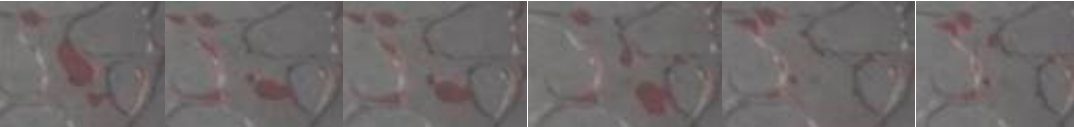
Figure 15. Variation of drop-like remaining oil in the same area with different displacement rates (the time from left to right was 729, 1160, 1500, 1990, 2300, and 2633 s ) . For the remaining columnar oil, at the displacement rate of 0.1 mL/min (i.e., when the cumulative PV number is 11.2), part of the remaining columnar oil is displaced at the end of displacement, but about half of the remaining oil remains in the pores. When the displacement rate is increased to 0.2 mL/min (i.e., when the cumulative PV number is 20.7), the remaining columnar oil is unchanged. This shows that this part of the remaining oil cannot be used in this displacement rate. When the displacement rate continues to increase to 0.3 mL/min (i.e., when the cumulative PV number is 39.2), the remaining columnar oil still cannot be driven. When the displacement intensity is 0.4 mL/min (i.e., the cumulative PV number was 56.6), the shape of the remaining oil pair changes significantly, and the area of the remaining oil becomes smaller. When the displacement intensity is increased to 0.5 mL/min (i.e., the cumulative PV number was 80.0), the remaining oil cannot be displaced (see Figure 16). When the water injection rate increases from 0.05 to 0.5 mL/min, the columnar remaining oil area decreases from 0.098 to 0.043 mm 2 . The oil displacement efficiency was increased by 55.67%.